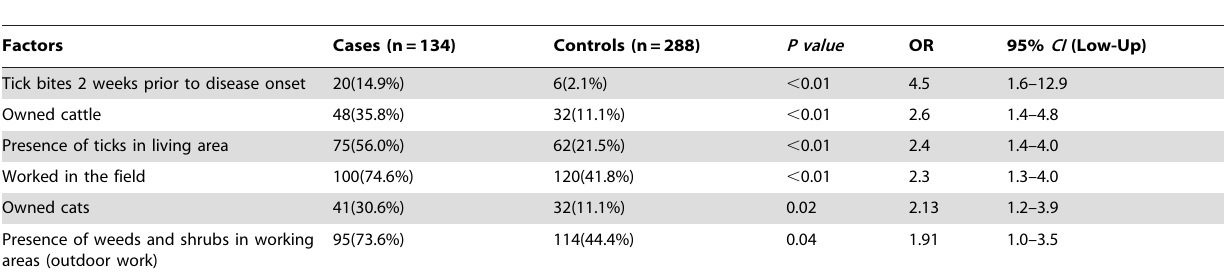
Table 4. Factors associated with SFTS, multivariate analysis, central and eastern China,